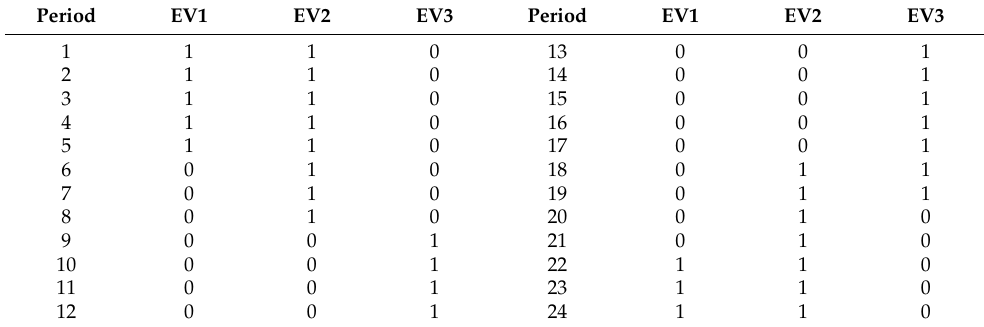
Table 1. Electric vehicles’ charging time.